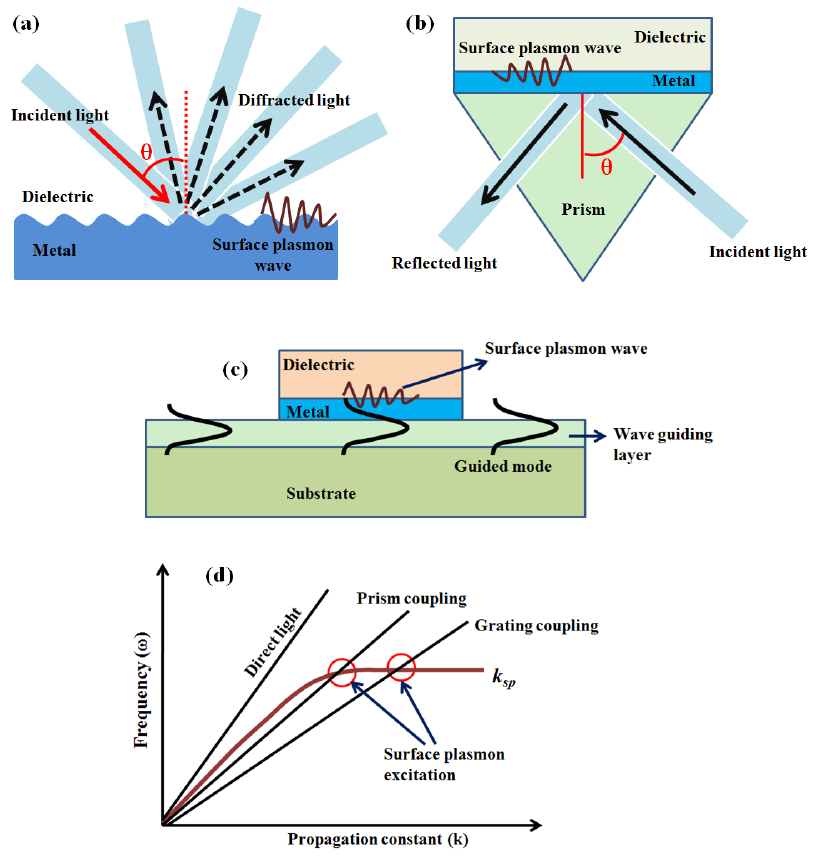
Figure 1. The schematic of ( a ) grating-; ( b ) prism-; ( c ) waveguide-based coupling configurations for SPR generation and ( d ) the surface plasmon excitation possibilities by using evanescent wave in the dispersion curves.